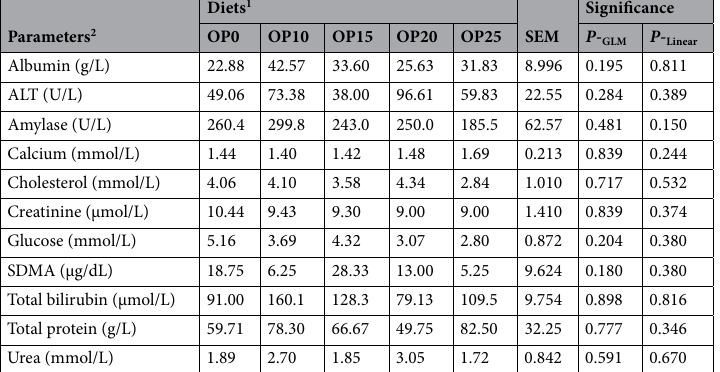
Table 4. Effects of incremental levels of dietary olive pomace on serum biochemical parameters in Jumbo quail. 1 Diets: OP0 a standard grower diet without olive pomace, OP10 a standard grower diet with 100 g/kg olive pomace, OP15 a standard grower diet with 150 g/kg olive pomace, OP20 a standard grower diet with 200 g/kg olive pomace, OP25 a standard grower diet with 250 g/kg olive pomace. 2 Parameters: ALT alanine transaminase, SDMA symmetric